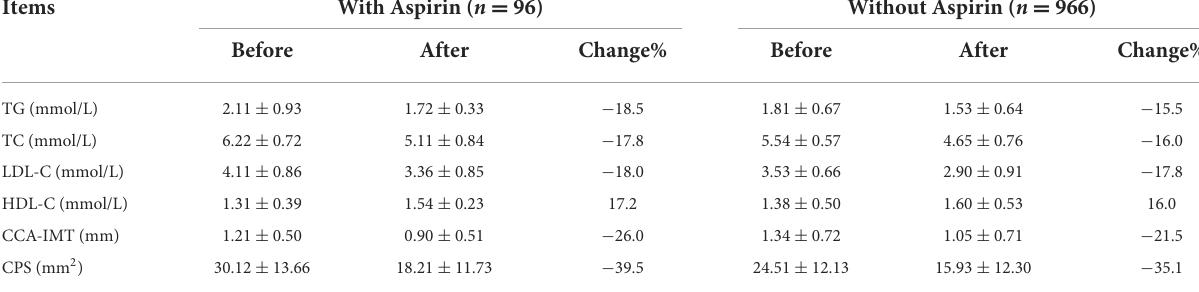
TABLE 12 Effect of coadministration of aspirin (100mg daily) on NK